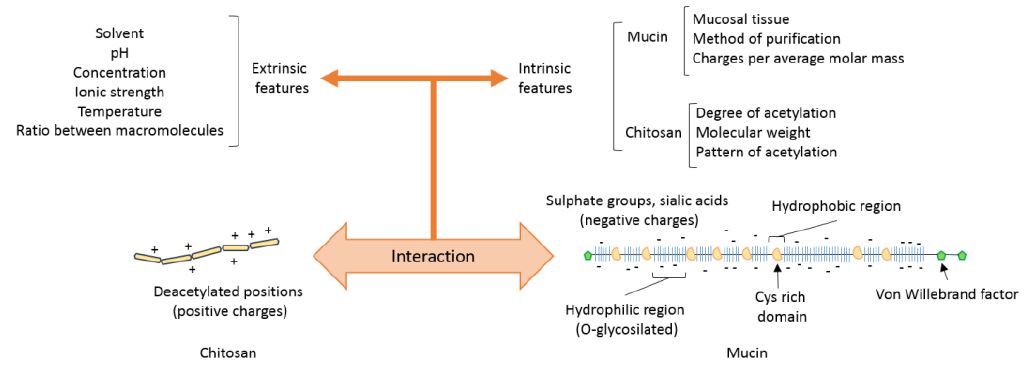
Figure 6. Intrinsic and extrinsic features that alter the interactions between chitosan and mucin.